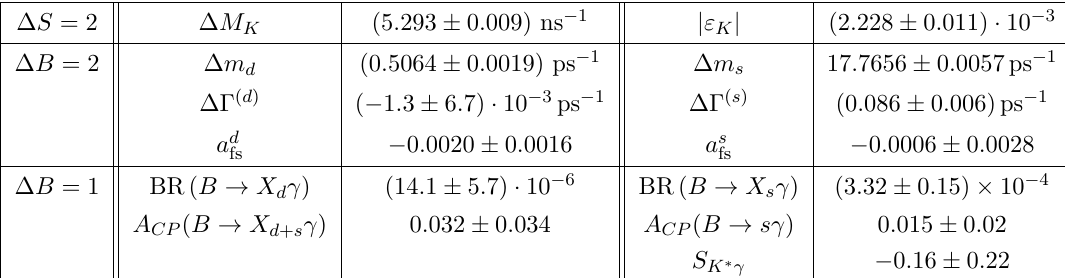
) have a cut on the d,s γ